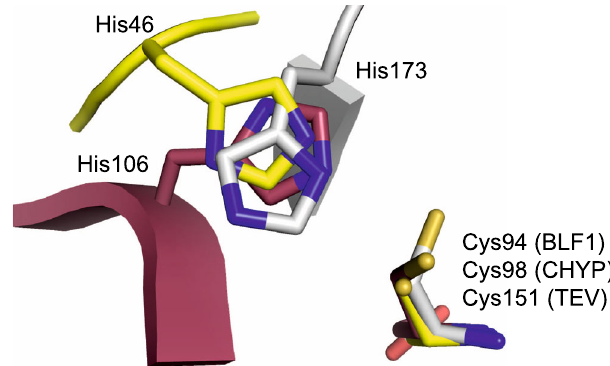
Fig. 5 Superposition of the catalytic histidine from the three families. Local superposition of the catalytic histidine and cysteine residues from BLF1 (Cys94/His106; maroon), TEV (Cys151/His46; yellow), and CHYP Cif/ AvrPphB (Cys98/ His173; white). In both BLF1 and TEV, the imidazole rings occupy the same approximate position and form a hydrogen bond with their respective cysteine residues using the same, N ε 2 , Nitrogen, despite differences in the position of the main chain. In contrast, in Cif, the main chain approaches from a third location, to leave the imidazole ring of His173 occupying a similar position but utilizing the nitrogen N δ 1 to generate a hydrogen bond with its catalytic cysteine.